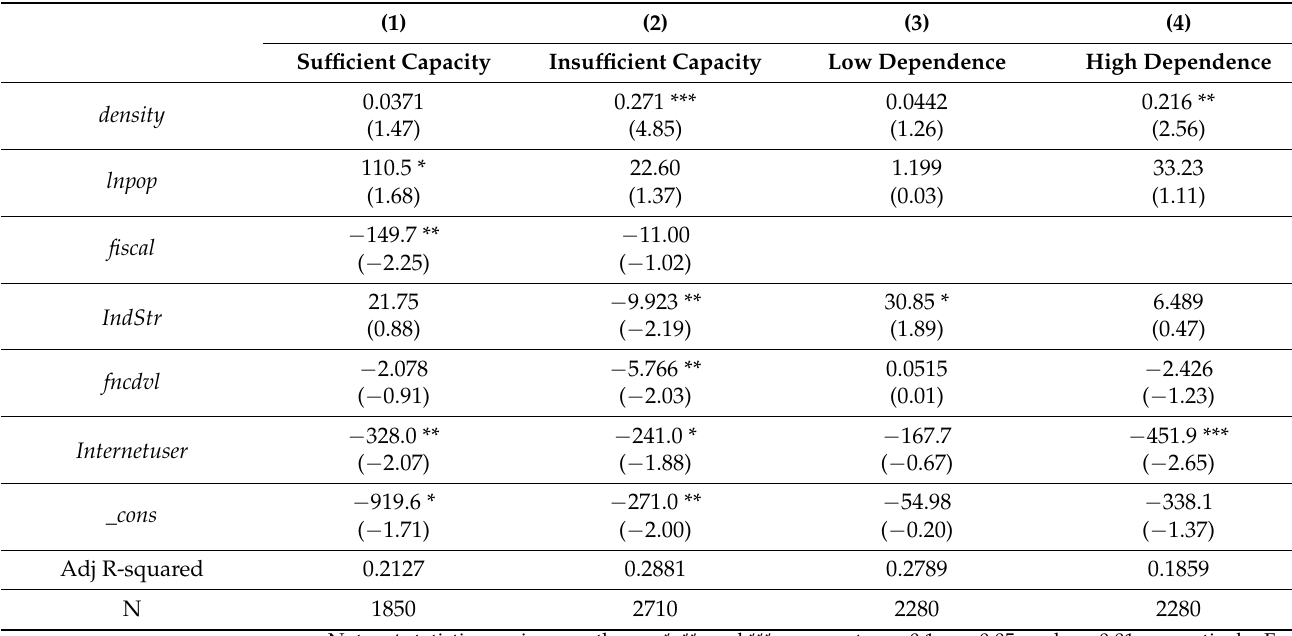
Table 8. Heterogeneous effects: impact of density on